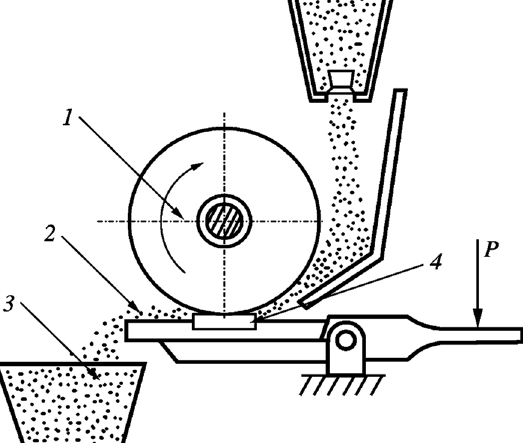
Figure 3. Scheme of a test setup for assessing the abrasive wear resistance of specimens during tests with non-fixed abrasive: 1—rubber disk, 2—sand, 3—container for abrasive, and 4—specimen. Reprinted from Ref. [2].